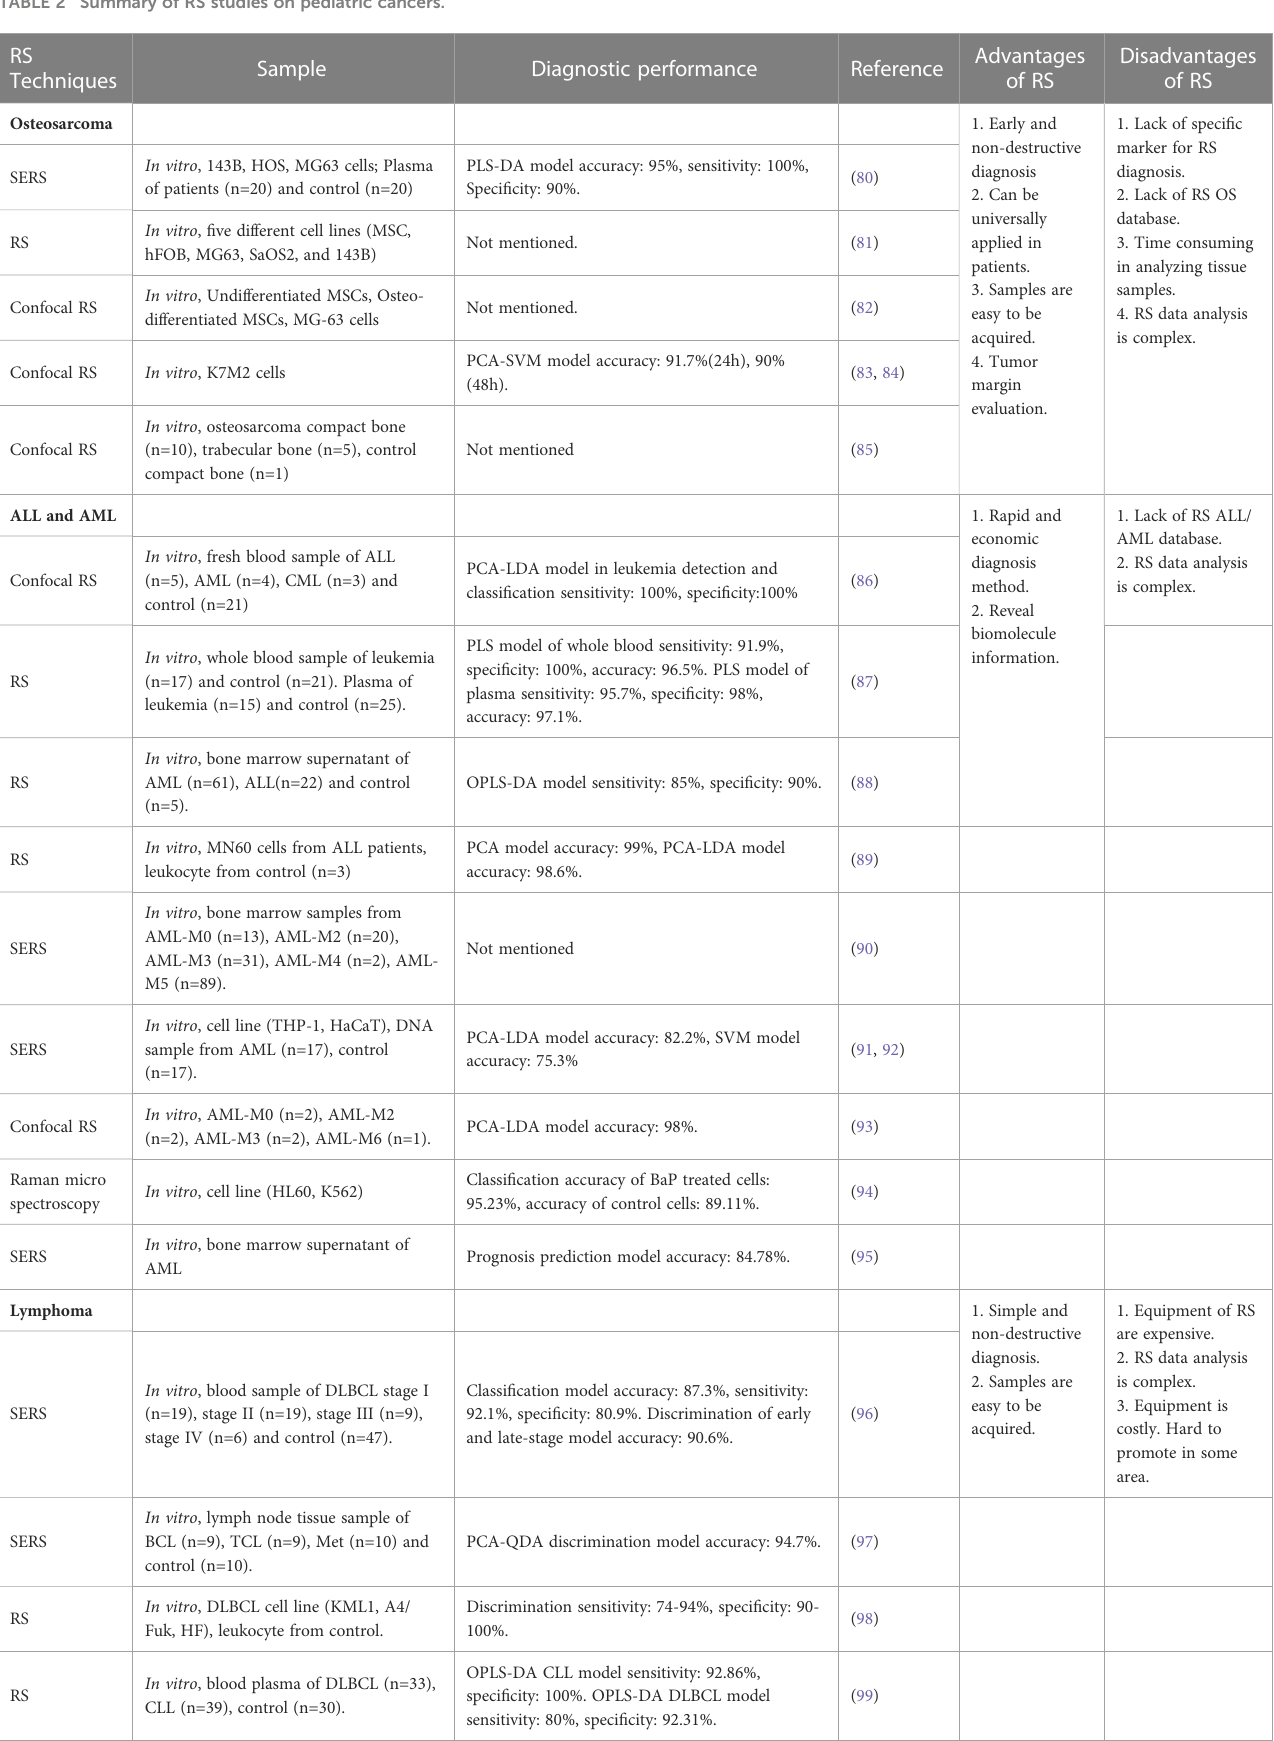
TABLE 2 Summary of RS studies on pediatric